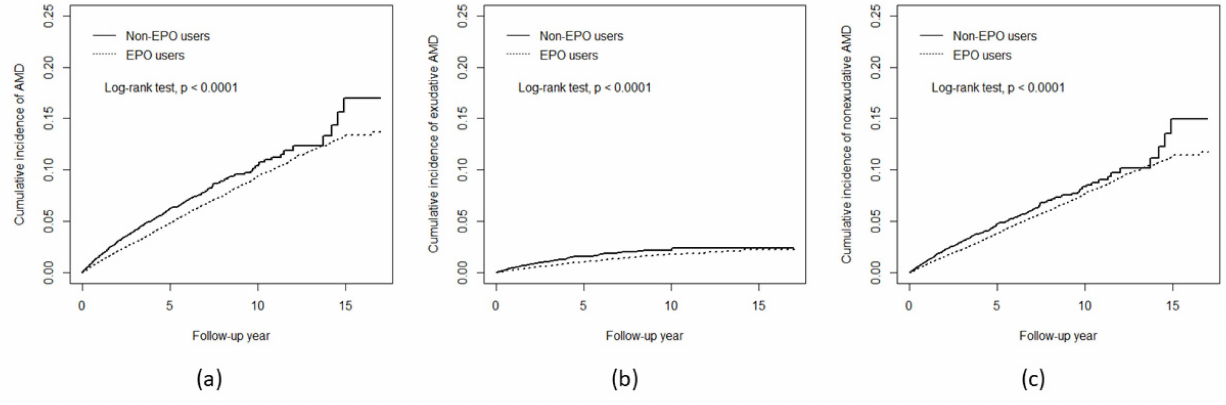
Figure 1. Cumulative incidence for ( a ) AMD, ( b ) exudative AMD, and ( c ) non-exudative AMD in two EPO